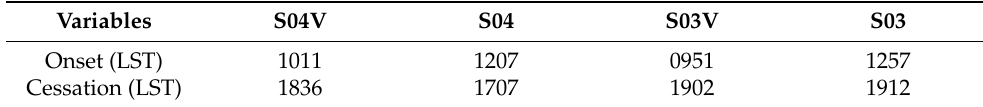
Table 5. The simulated characteristics of sea breeze on 15 July